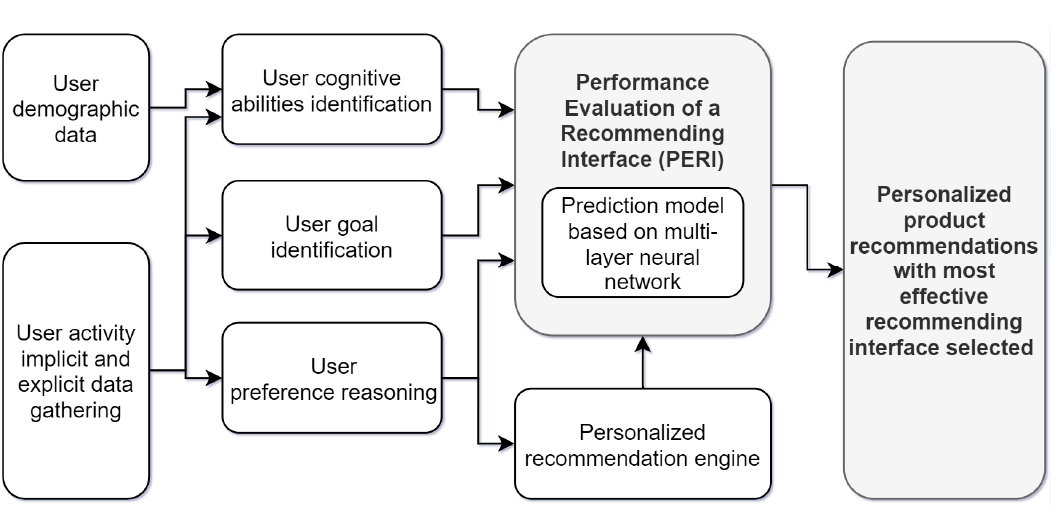
Figure 1. The framework for performance evaluation of a recommending interface.